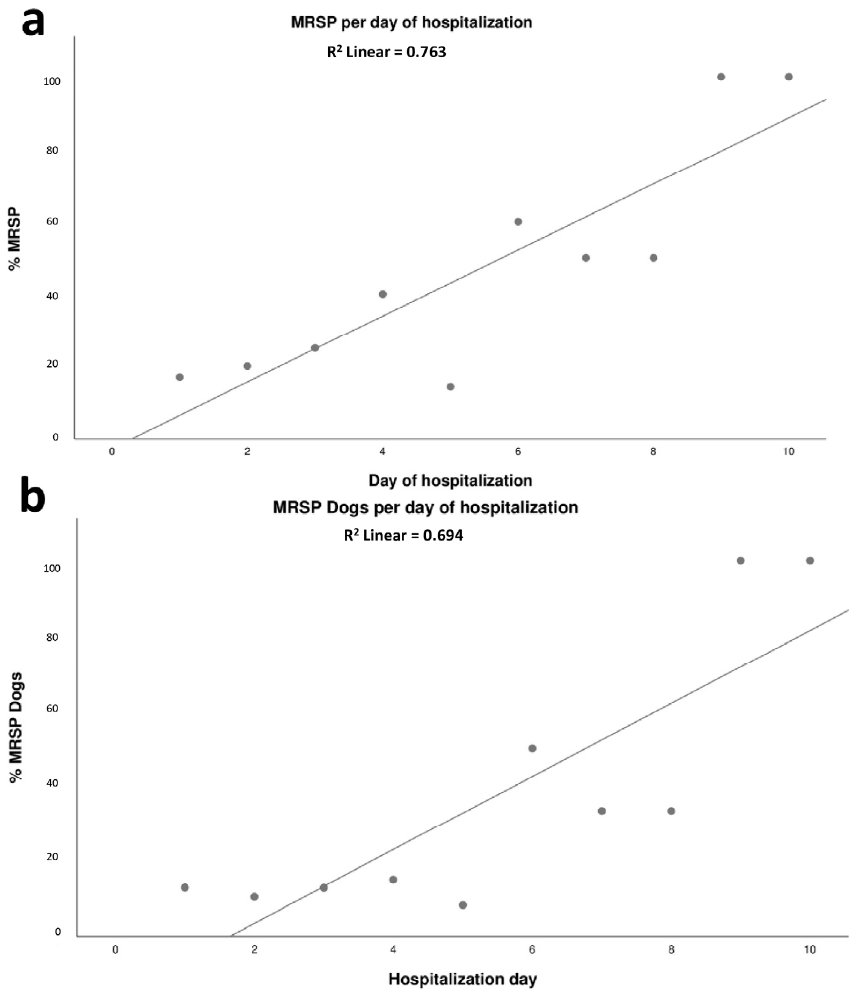
Figure 2. Relationship between the day of hospitalization and the proportion of MRSP strains ( a ); relationship between the day of hospitalization and proportion of dogs positive for MRSP strains ( b